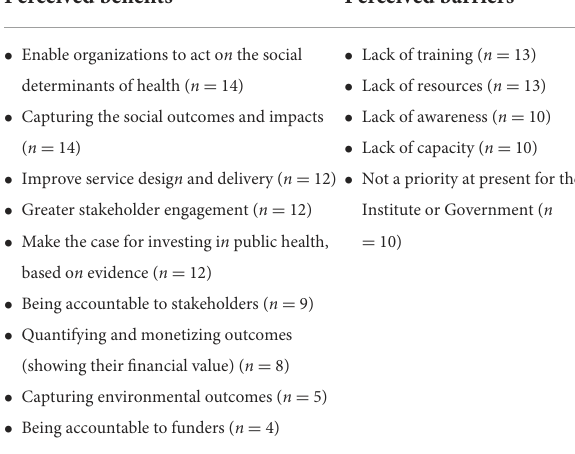
TABLE 1 Perceived benefits of and barriers reported by survey respondents to capturing and measuring social